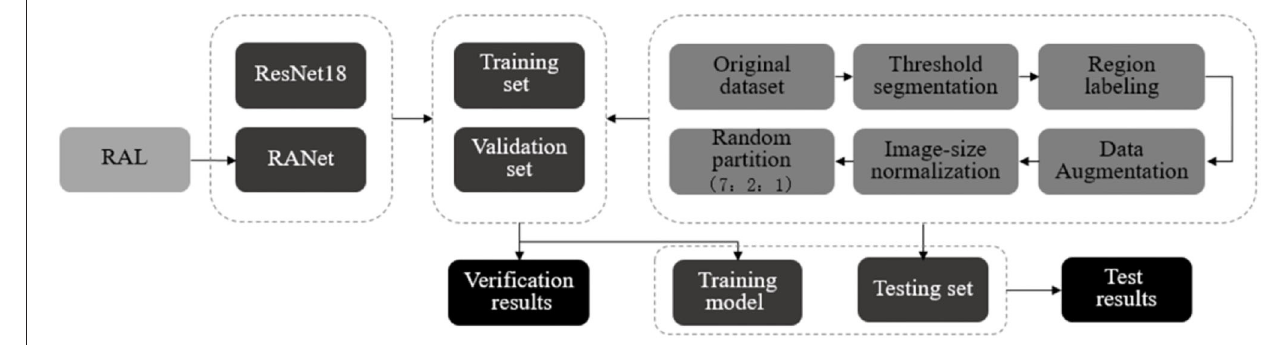
FIGURE 16 | Disease identification process.